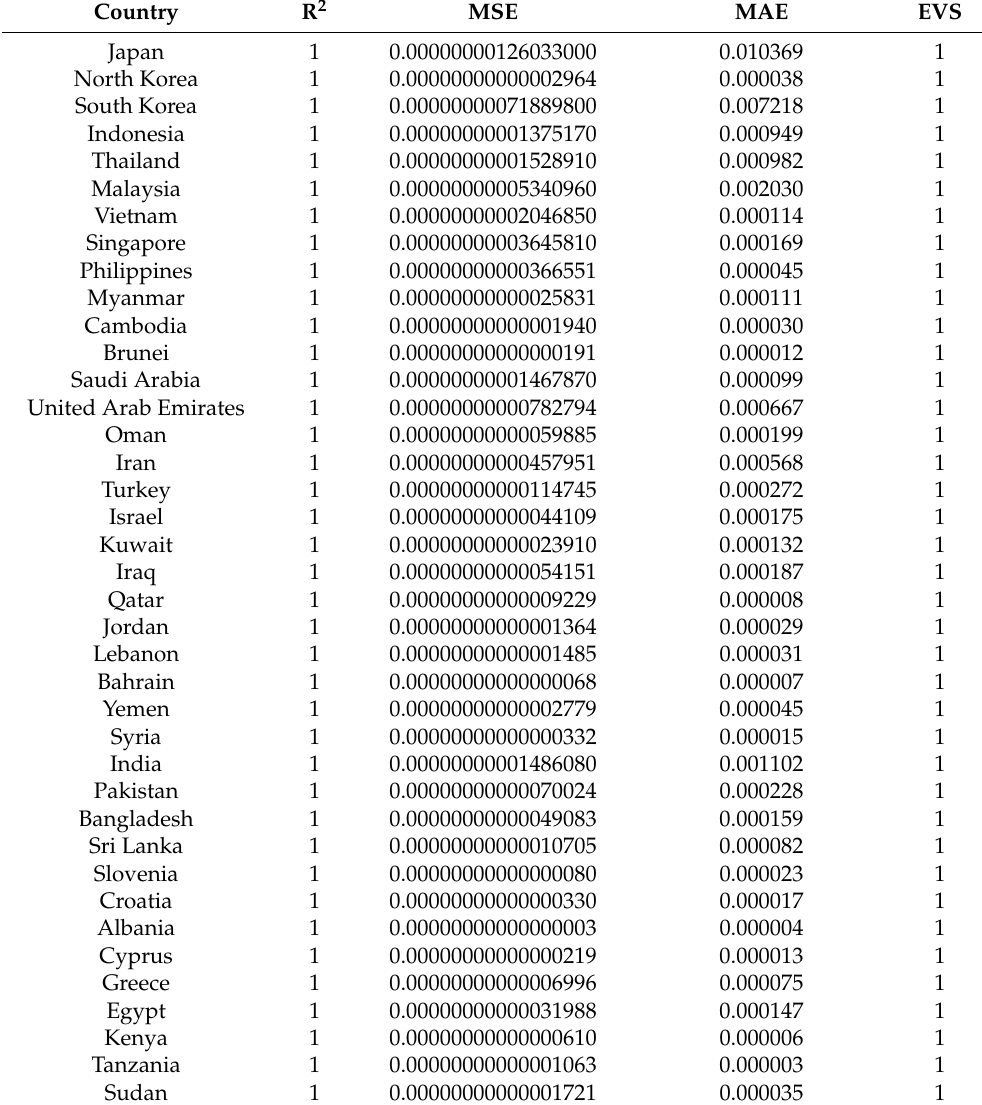
Table 4. Evaluation of the effect of the extreme random forest regression